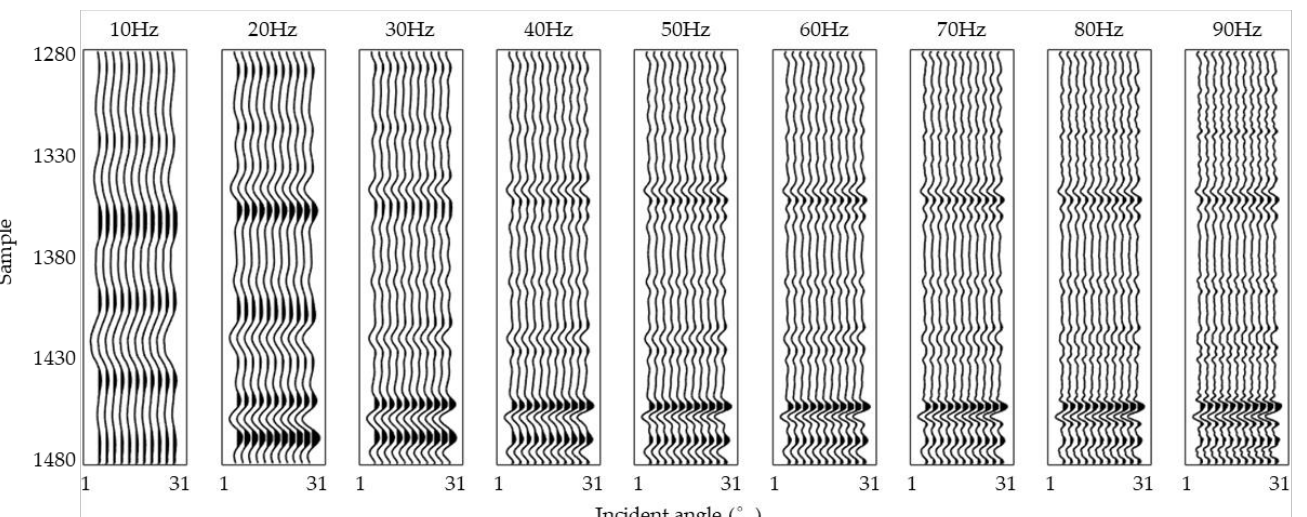
Figure 7. The estimated results of the attenuated and anisotropic parameters using Chapman model in different frequency and incident angle. The black lines are the measured values from well-logging.